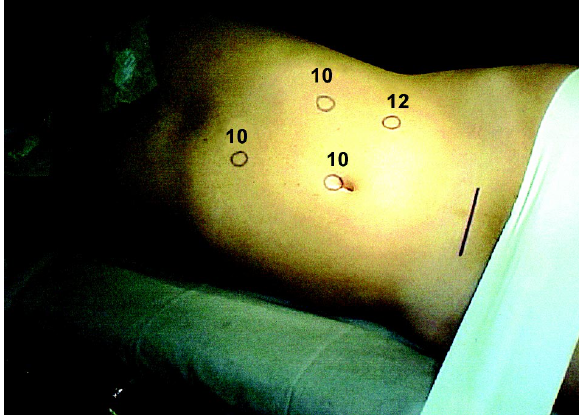
Figure 1 – Patient positioned on the surgical table, with draw- ings of sites and diameters of trocars (the numbers indicate the diameter in millimeters) and the Pfannestiel